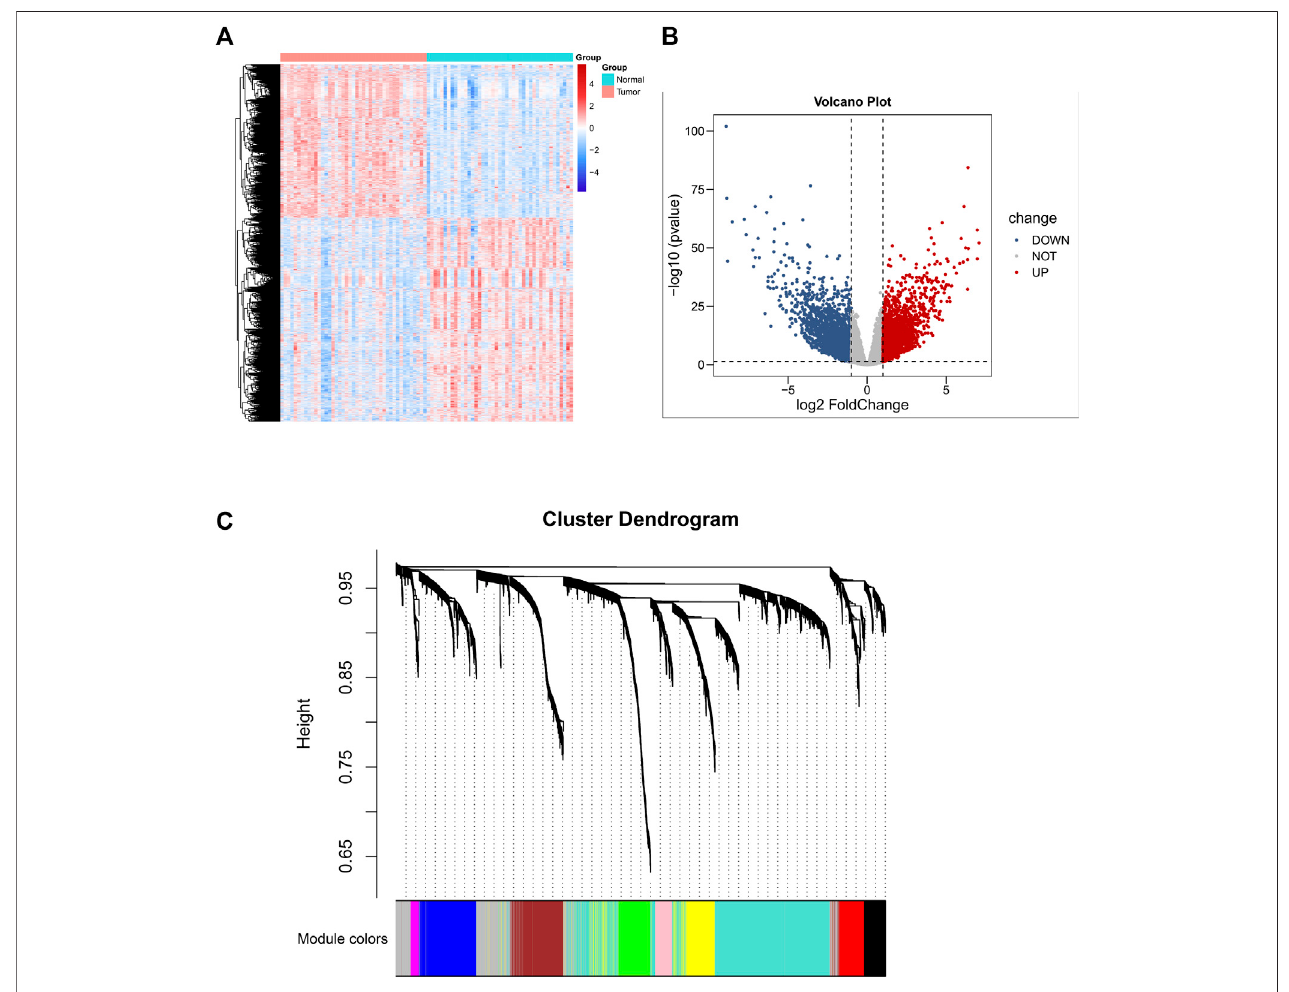
FIGURE 2 | Differential gene expression analysis based on 43 normal-tissue-matched HNSCC patients and construction of co-expression network. (A) Heatmap of differentiated expressed genes (DEGS). (B) Volcano plot of DEGS. (C) A cluster diagram of gene cluster of HNSCC.